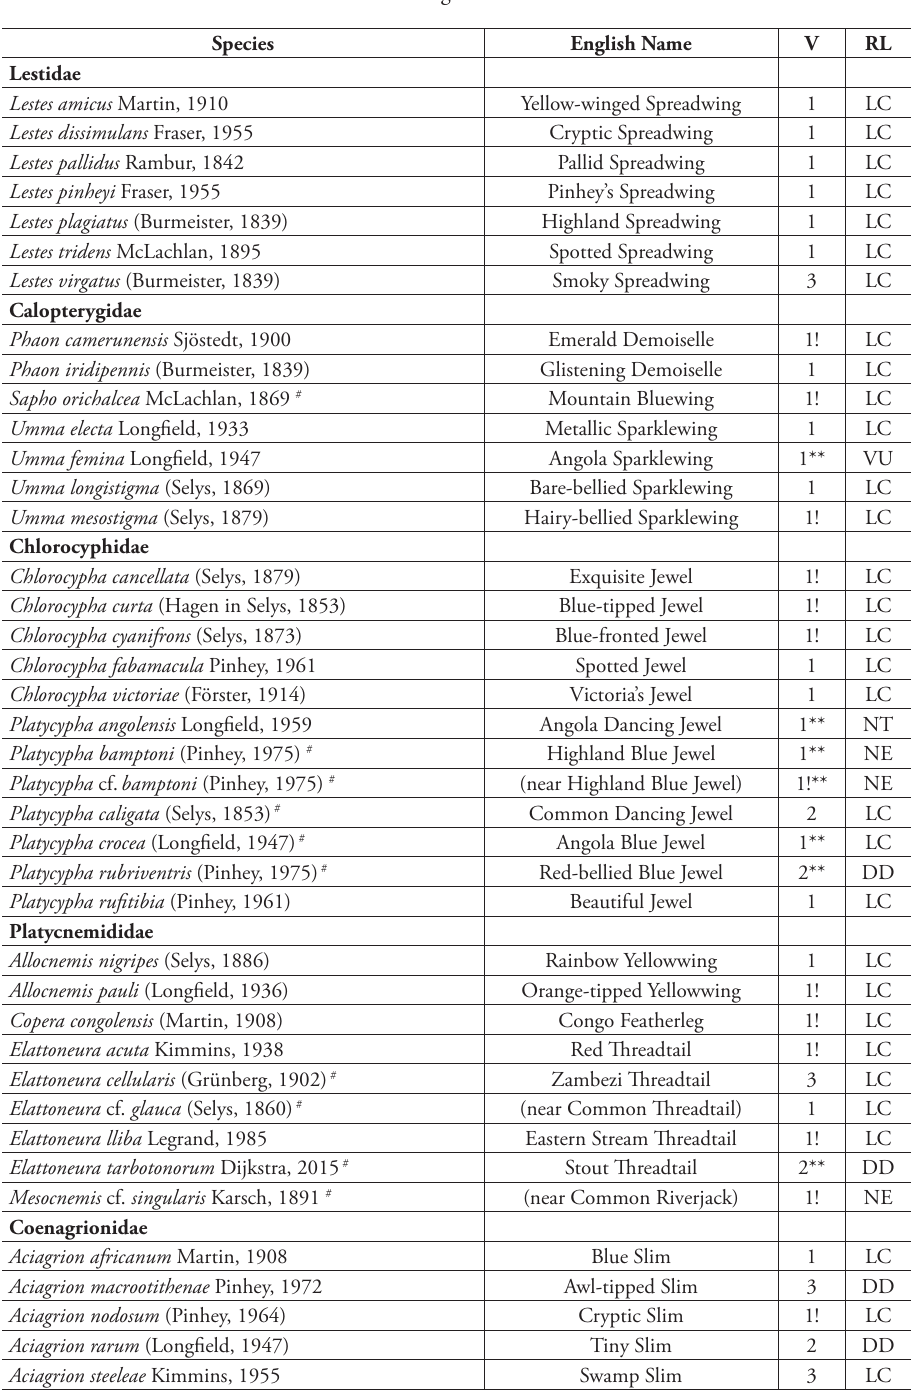
Table 1. Checklist of Odonata recorded from Angola.